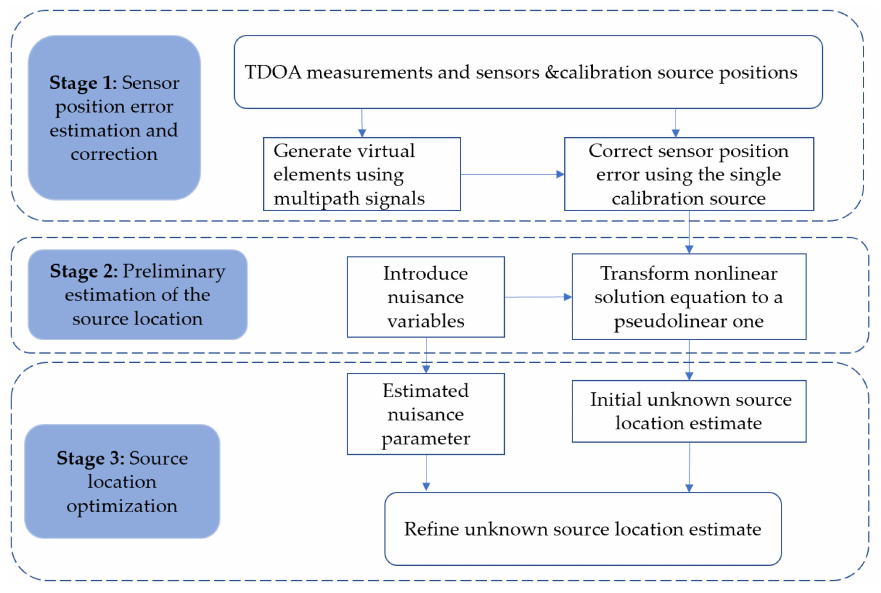
Figure 2. Implementation flow of unknown source localization. Step 1: Sensor position error estimation and